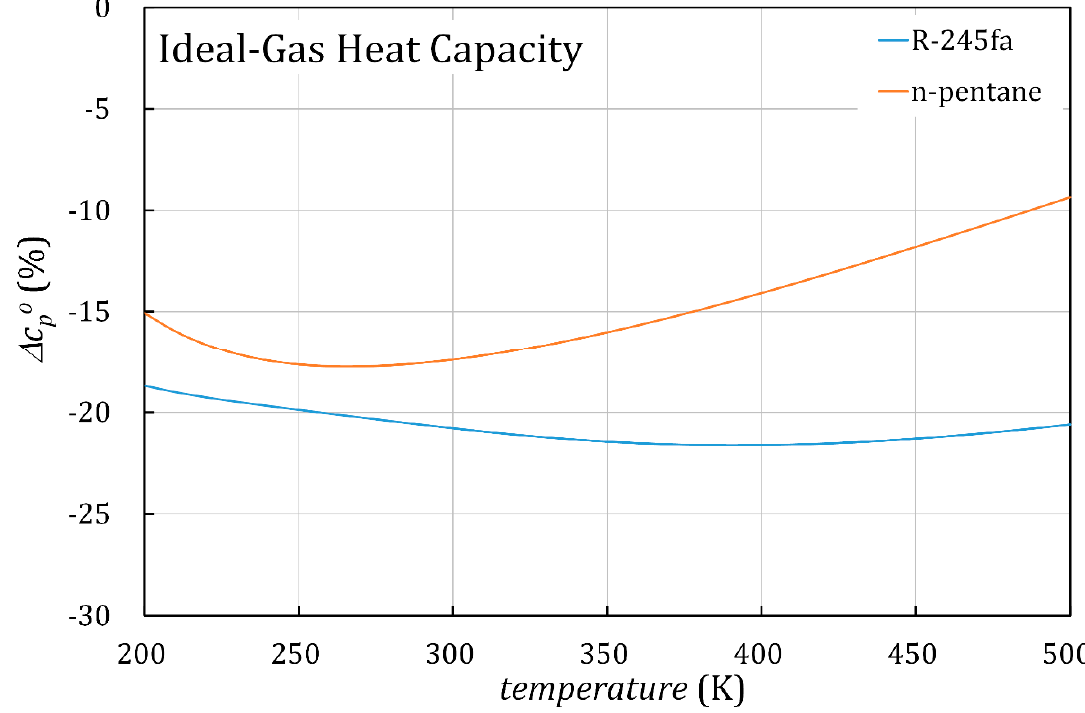
Figure 11. Comparison of the ideal-gas heat capacity at constant pressure of HFE-356mmz with that of R-245fa and n-pentane. The base line corresponds to the ideal-gas heat capacity of HFE-356mmz.